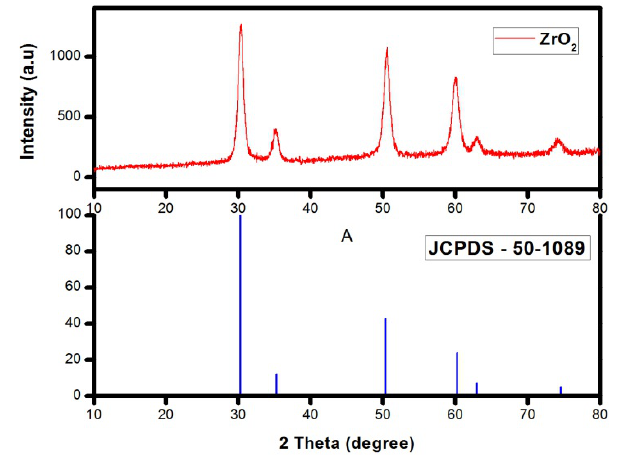
Fig. 1. XRD pattern of nano